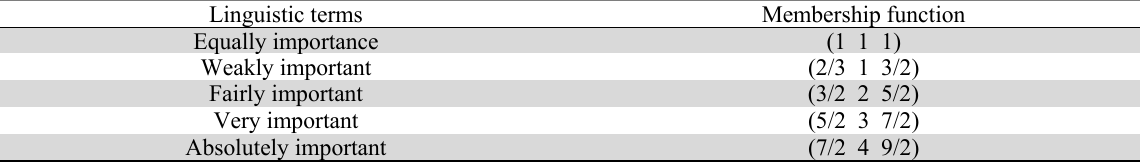
Transformation rules of linguistic variables ofdecision-makers Linguistic